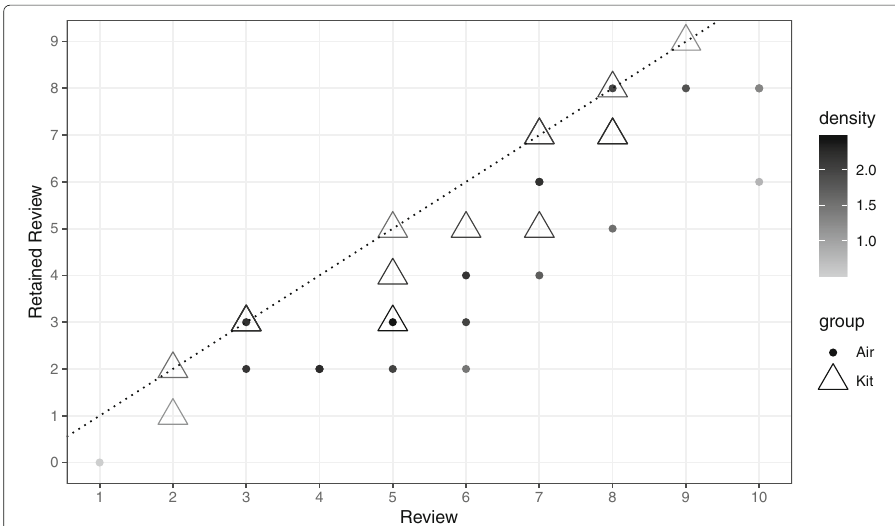
Fig. 4 A scatter plot of review and retained review. Both metrics are related to reviewed knowledge. The farther away from the diagonal line, the more the user forgets. The Kit condition, represented by triangles, is able to retain more after the 2-week period when compared to the Air